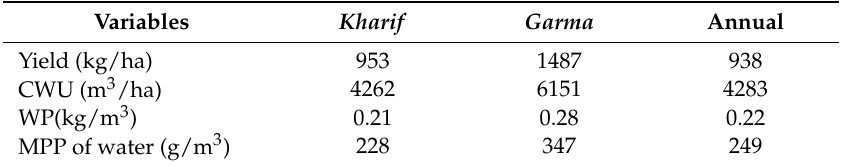
Table 2. Average season-wise rice yield, consumptive water use (CWU), WP, and marginal physical productivity (MPP) in the Koshi districts of Bihar (1991–2010).